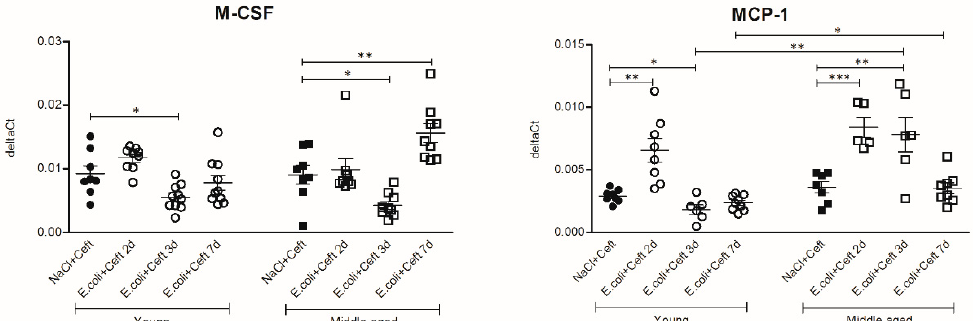
Figure 6. mRNA expressions of brain homogenate of immune regulatory mediators M-CSF and MCP-1, illustrated in deltaCts. Group size varies from n = 8 to 10. Parametric or non-parametric two-way ANOVA (factors: age and time point) were conducted and continuous variables were tested with post-hoc Mann–Whitney U tests or Student t -tests, depending on the distribution of the data. For non-parametric ANOVAs, ranked transformation of the data was performed. Data represent mean ± SEM, * p ≤ 0.05, ** p ≤ 0.01, *** p ≤ 0.001.